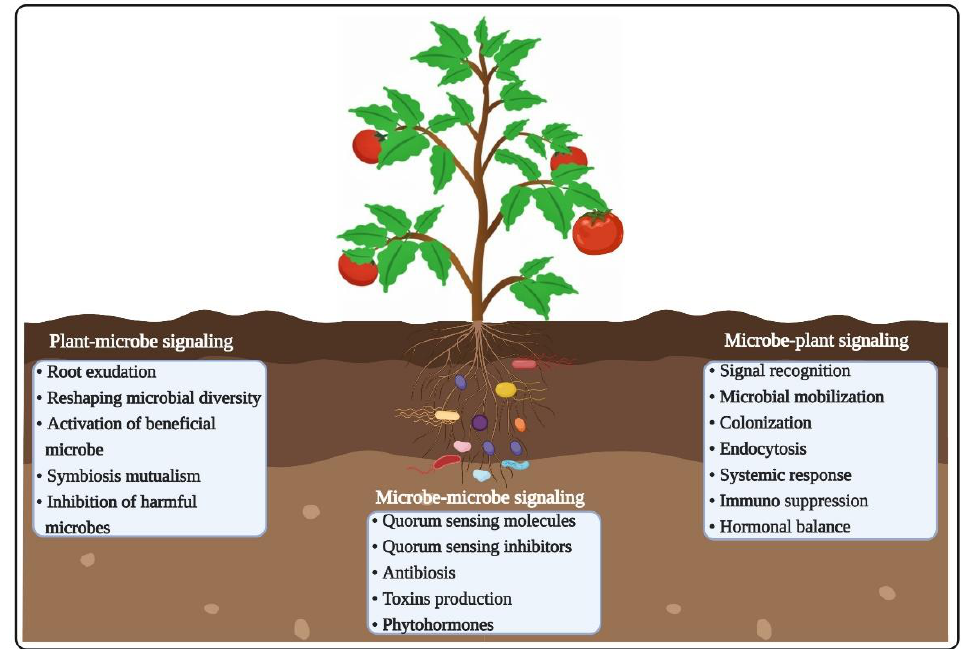
Figure 2. Schematic visualization of various interactions occurring in the plant holobiont. Numerous complex signaling pathways are involved in plant–microbiome crosstalk, including plant–microbe, microbe–microbe, and microbe–plant communications. The ultimate fate of plant–microbiome interactions depends on the chemistry of the rhizosphere, and the diversity and the composition of microbial communities.